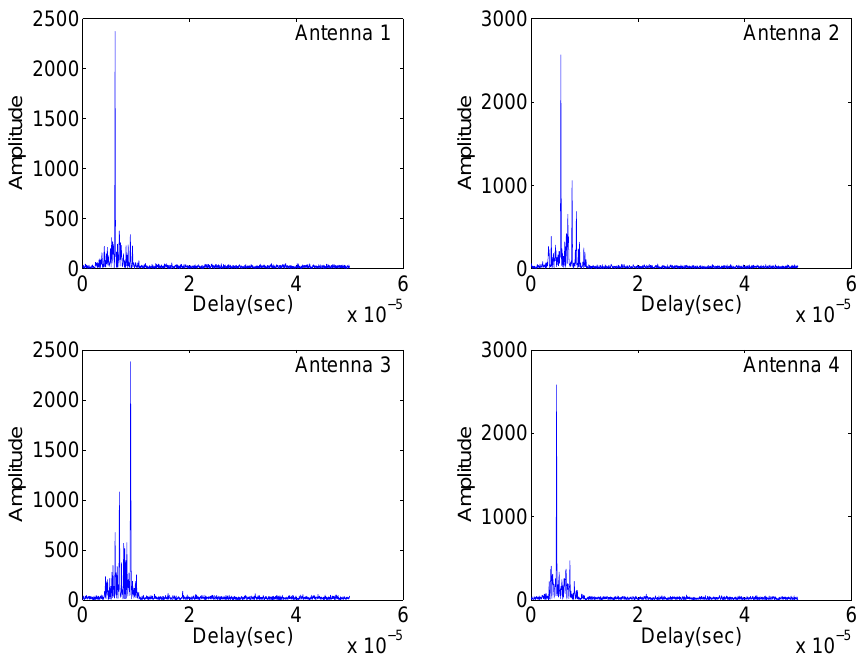
Figure 3. Matched filtering outputs of the four antennas in Case